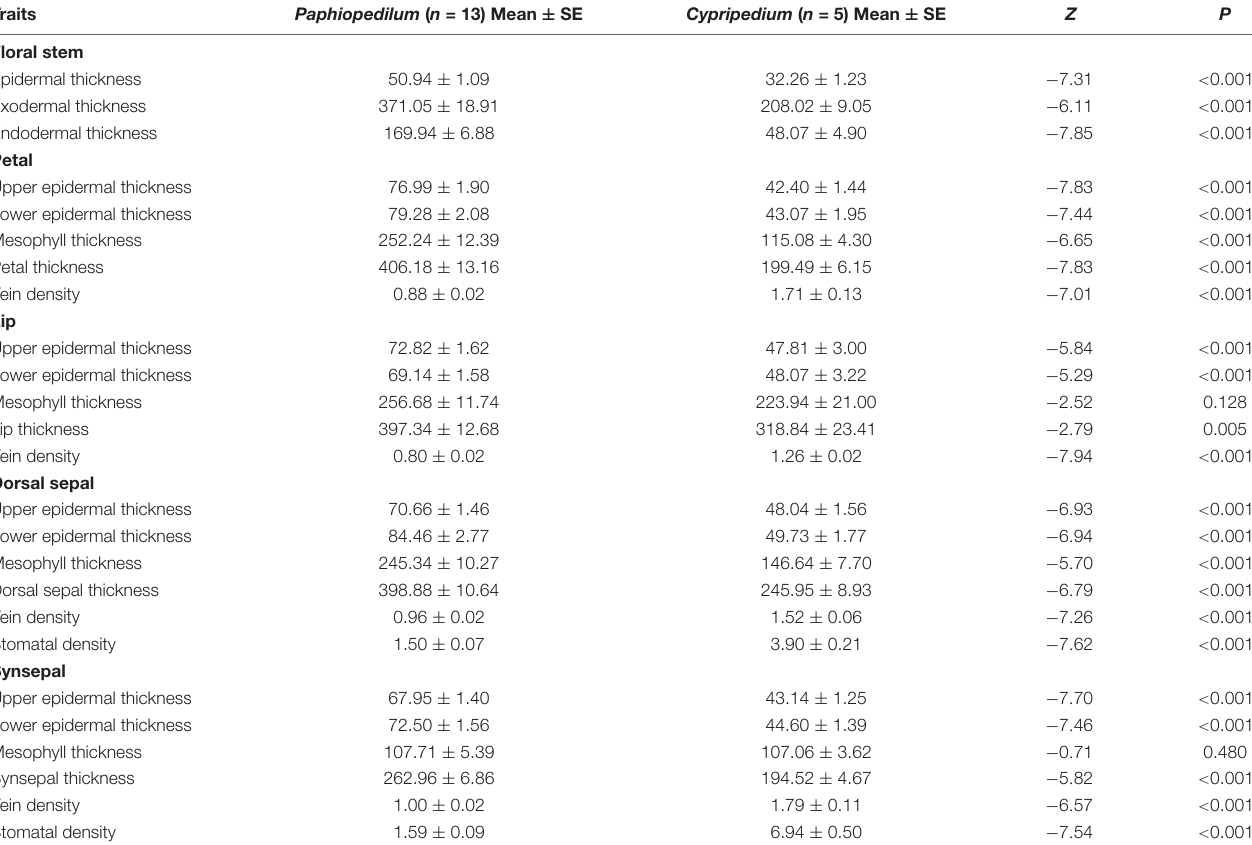
TABLE 2 | Contrasts in floral anatomical traits between Paphiopedilum and Cypripedium of floral functional traits for tested species.